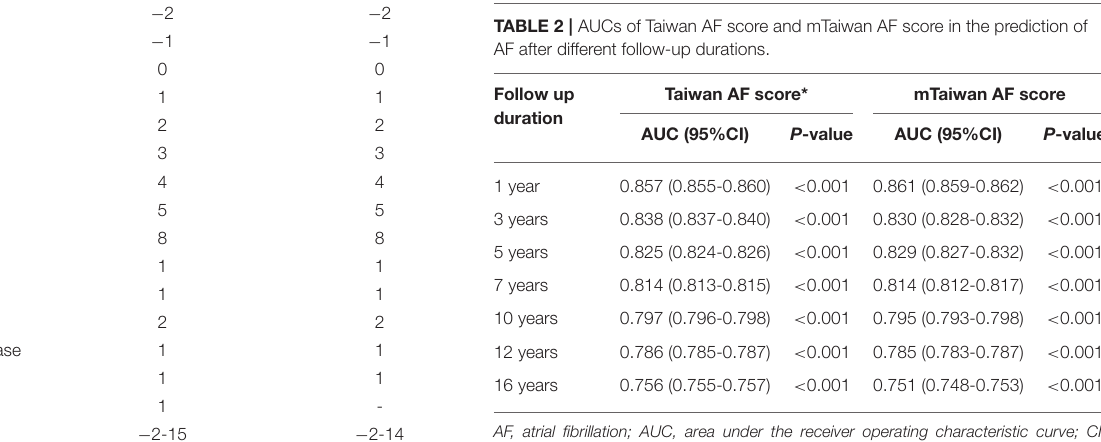
The areas under the ROC curve (AUCs) of original Taiwan AF score and mTaiwan AF score in predicting incident AF after different follow-up durations are shown in Table 2 . The AUCs of the mTaiwan AF scores are 0.861 [95% confidence interval (CI)